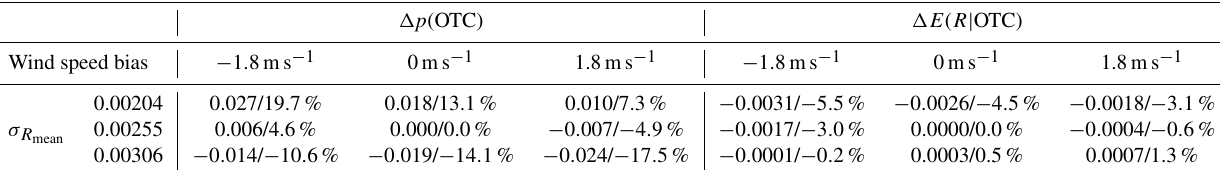
. The two numbers in each cell state the absolute and relative mean = 0 . 0026, mean